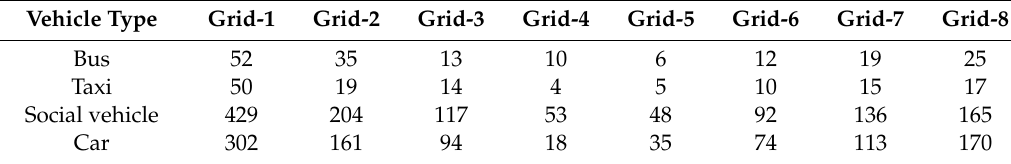
Table 2. Numbers of electric vehicles in di ff erent parts of the distribution